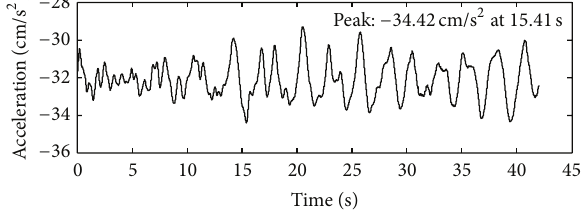
Figure 25: Acceleration time history (2).